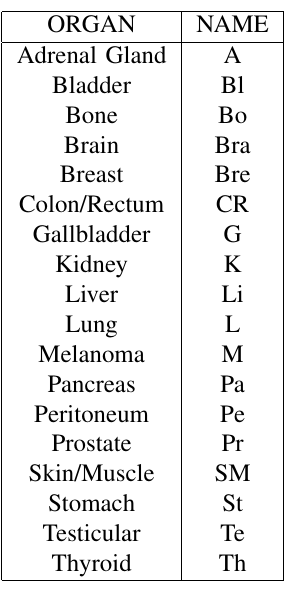
TABLE I: Symbols for